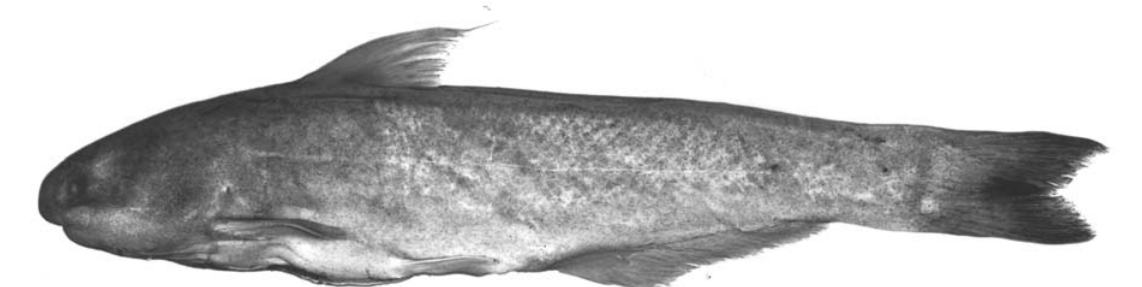
Fig. 27. Cetopsis motatanensis, paratype of Pseudocetopsis plumbeus motatanensis , male (right side, reversed), USNM 121268, 109 mm SL; Venezuela, Trujillo, río Motatán, 4 km below Motatán (approximately 9°24’N, 70°36’W).